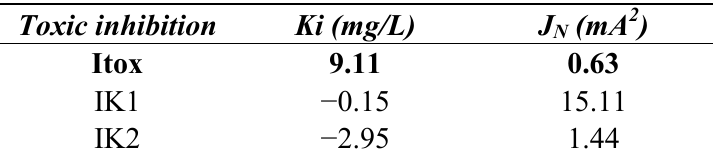
Table S3B. Bentazon 3 mg/L.